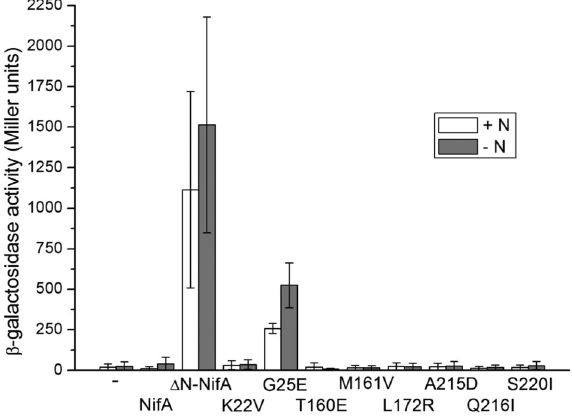
Figure 2. Transcriptional activity of NifA variant proteins in Escherichia coli JM109 (DE3) carrying pRT22 ( nifH::lacZ ). ( – ) indicates cells carrying pET-29a. Full-length NifA was expressed from pRAM1. D N-NifA indicates an N-truncated form of NifA expressed from pRAM2. Full-length NifA mutants, as indicated, were expressed from pET-29a-based plasmids. b -galactosidase expression experiments were performed in NFDM medium (31) with 20 mM of ammonium chloride ( + N) or 0.2% casamino acids ( – N), in the absence of O 2 . Data are reported as the mean±SD of 3 independent assays. b -galactosidase activity is reported as Miller